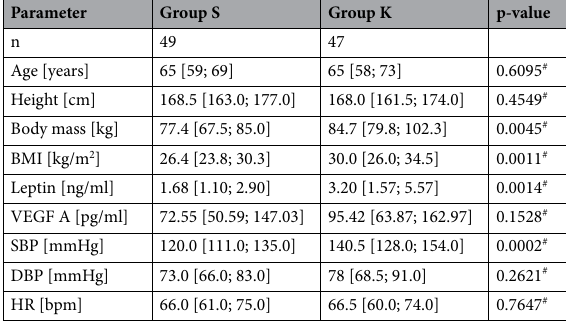
Table 3. Baseline characteristics of group S and K. Data are presented as median [Q1; Q3]. BMI: body mass index; bpm: beats per minute; DBP: diastolic blood pressure; HR: heart rate; Q1: first quartile; Q3: third quartile; SBP: systolic blood pressure; VEGF A: vascular endothelial growth factor A. # Mann–Whitney